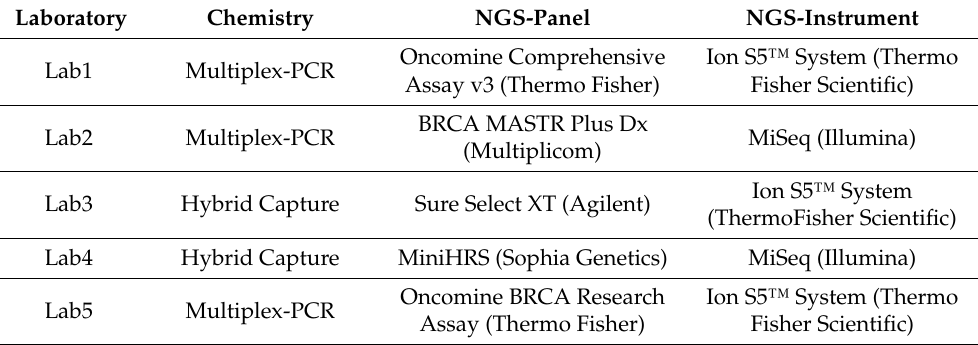
Table 2. RTT tumor BRCA1/2 analysis strategies.